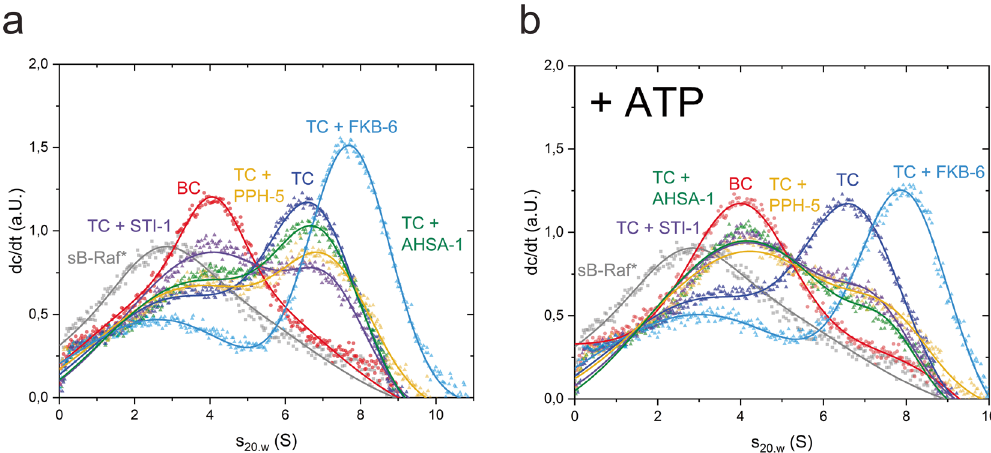
Figure 2. Influence of HSP-90 cochaperones on the sB-Raf•CDC-37•HSP-90 ternary complex. (a) Changes of sB-Raf•CDC-37•HSP-90 ternary complex (TC) induced by the presence of HSP-90 cochaperones. (b) Influences of ATP on complexes formed with HSP-90 cochaperones. BC stands for sB-Raf•CDC-37 binary